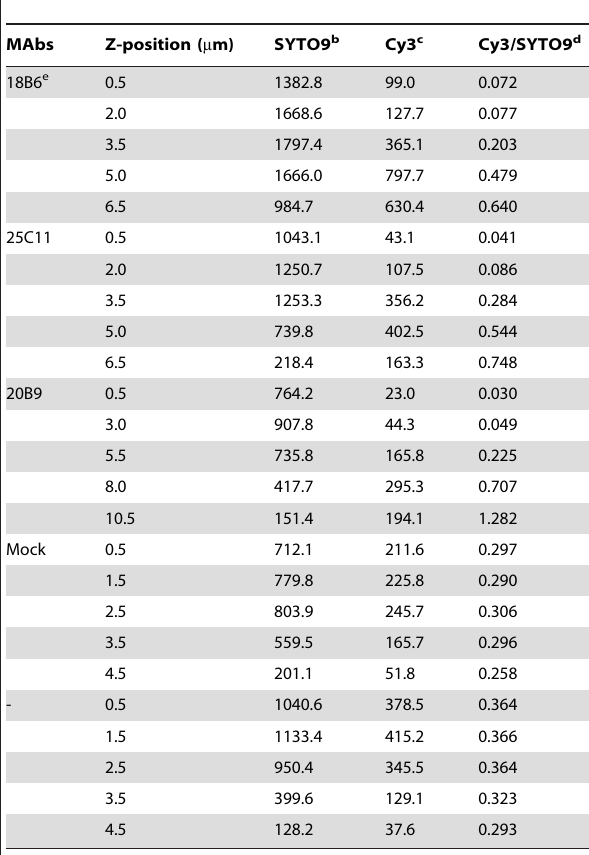
Table 3. Fluorescence quantities of the immuno-probed biofilms. a